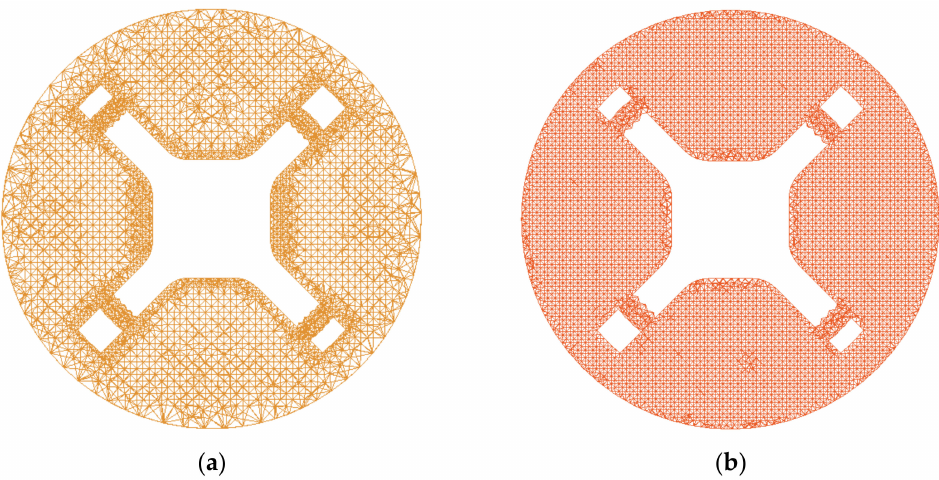
Figure 6. Cross sections of two grid numbers: ( a ) 0.27 million grid number; ( b ) 1 million grid number.